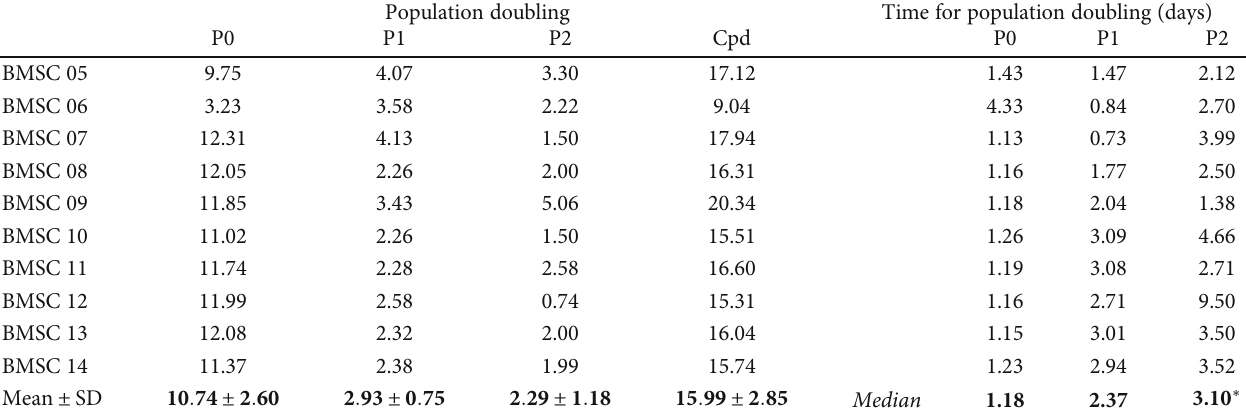
Table 3: Number of population doublings and the doubling time for each BMSC passage.